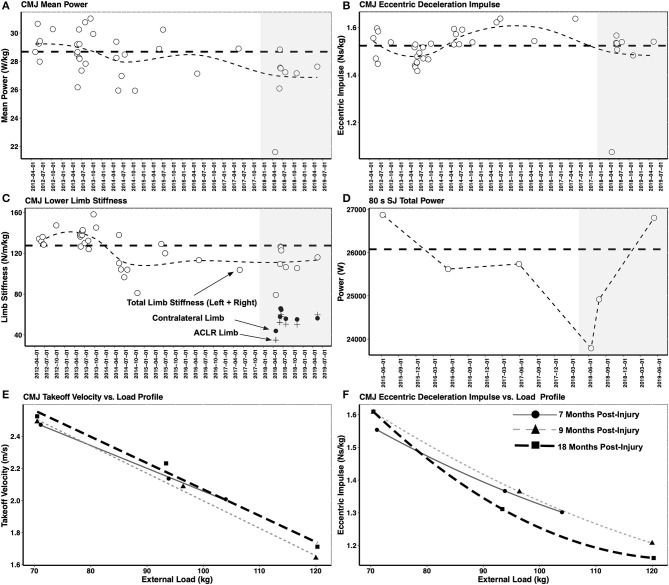
(A–D) Depict lower body mechanical muscle function assessed in the countermovement jump (CMJ) and squat jump (SJ). Shaded gray zone depicts the post-injury period. Thick horizontal dashed line shows the mean pre-injury value. Thin dashed line depicts trendline over the testing period. To highlight the importance of considering the strength of each limb independently alongside a measure of interlimb asymmetry, the ACLR limb stiffness (+ symbol) and non-injured limb stiffness (• symbol) are shown alongside the total limb stiffness (o symbol). While the interlimb asymmetry in limb stiffness was negligible at the 18 months post-injury time point, it can be seen that the total limb stiffness had still not fully recovered to the pre-injury mean value. (E) Shows the CMJ takeoff velocity vs. load profile and (F) shows the CMJ eccentric deceleration impulse vs. load profile in the post-injury testing period.